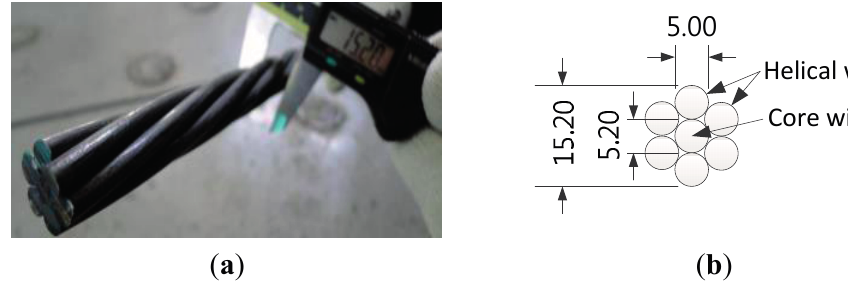
Figure 1. ( a ) Shape and ( b ) dimensions of PC